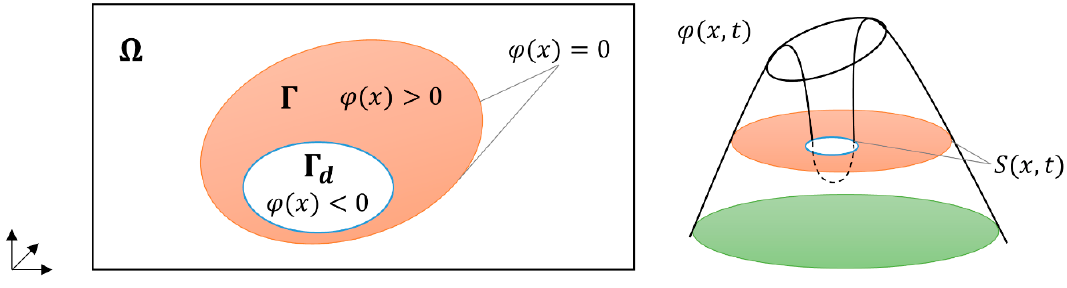
Figure 2. The level set function and its domains adapted from Jia, Beom [20].